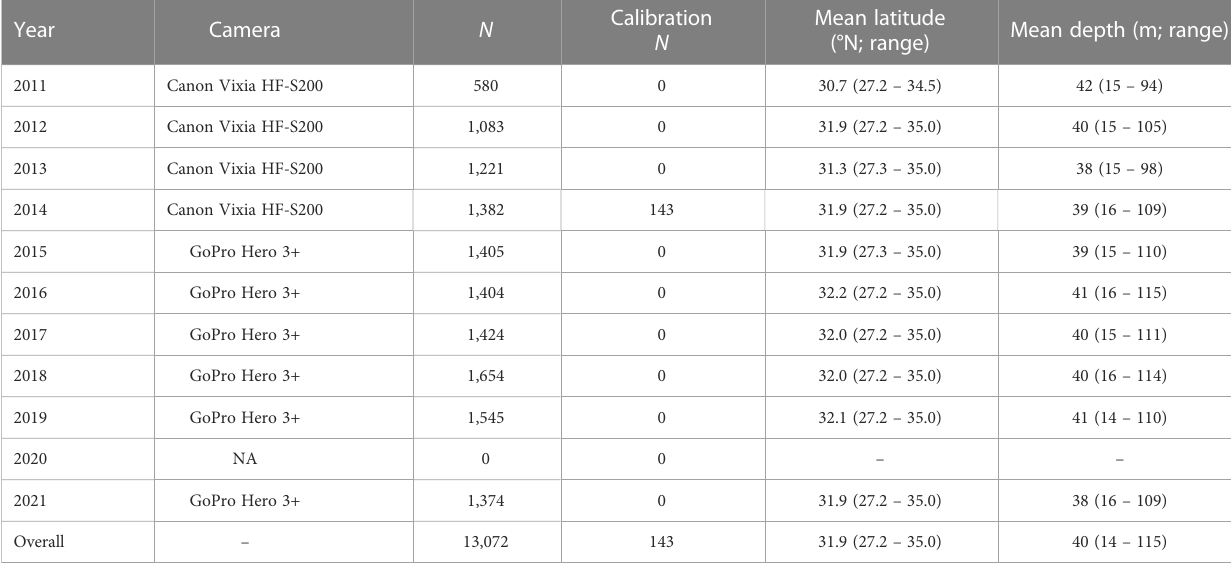
TABLE 2 Annual video sampling information for the Southeast Reef Fish Survey, 2011 – 2021, included in the